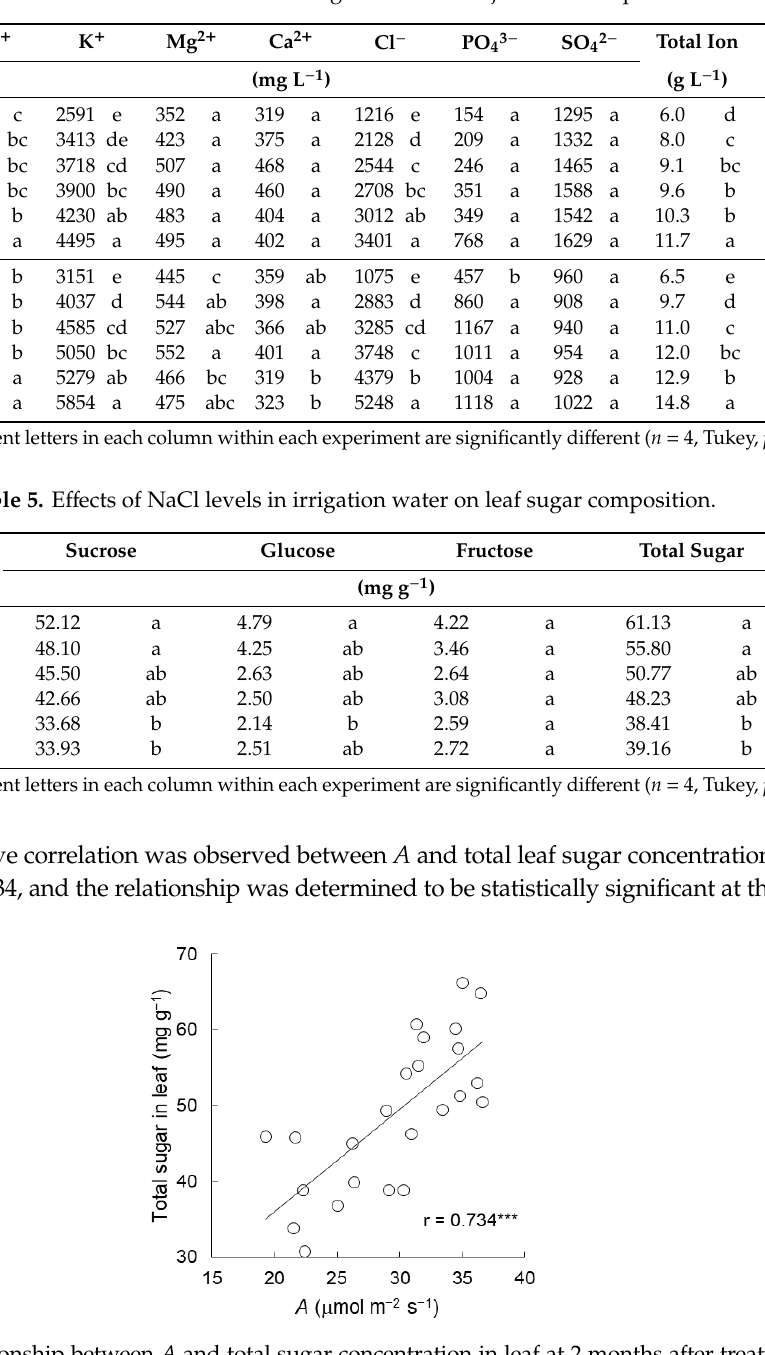
Table 4. E ff ects of NaCl levels in irrigation water on juice ion composition.